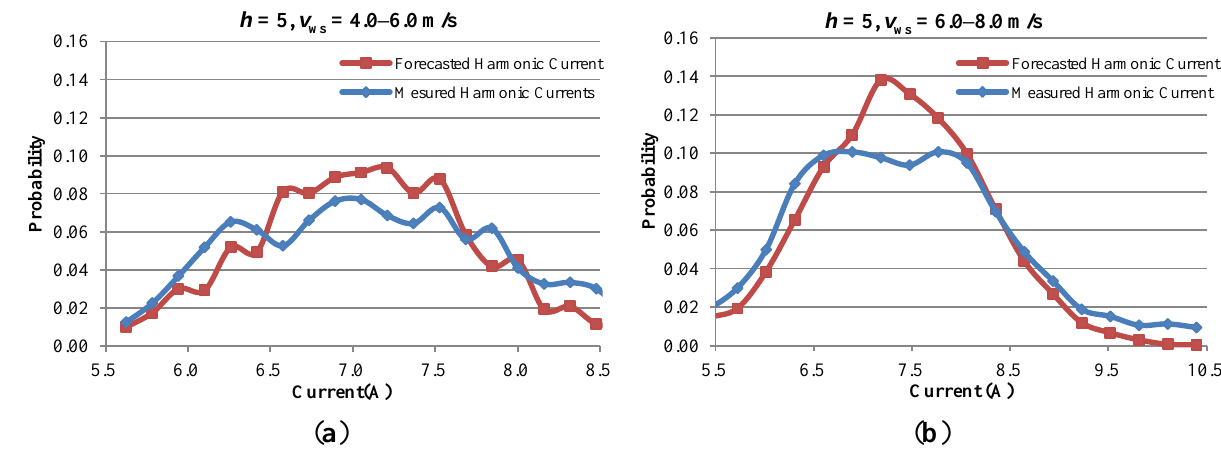
Figure 10. Measured and forecasted probability distributions of the 7th harmonic currents.